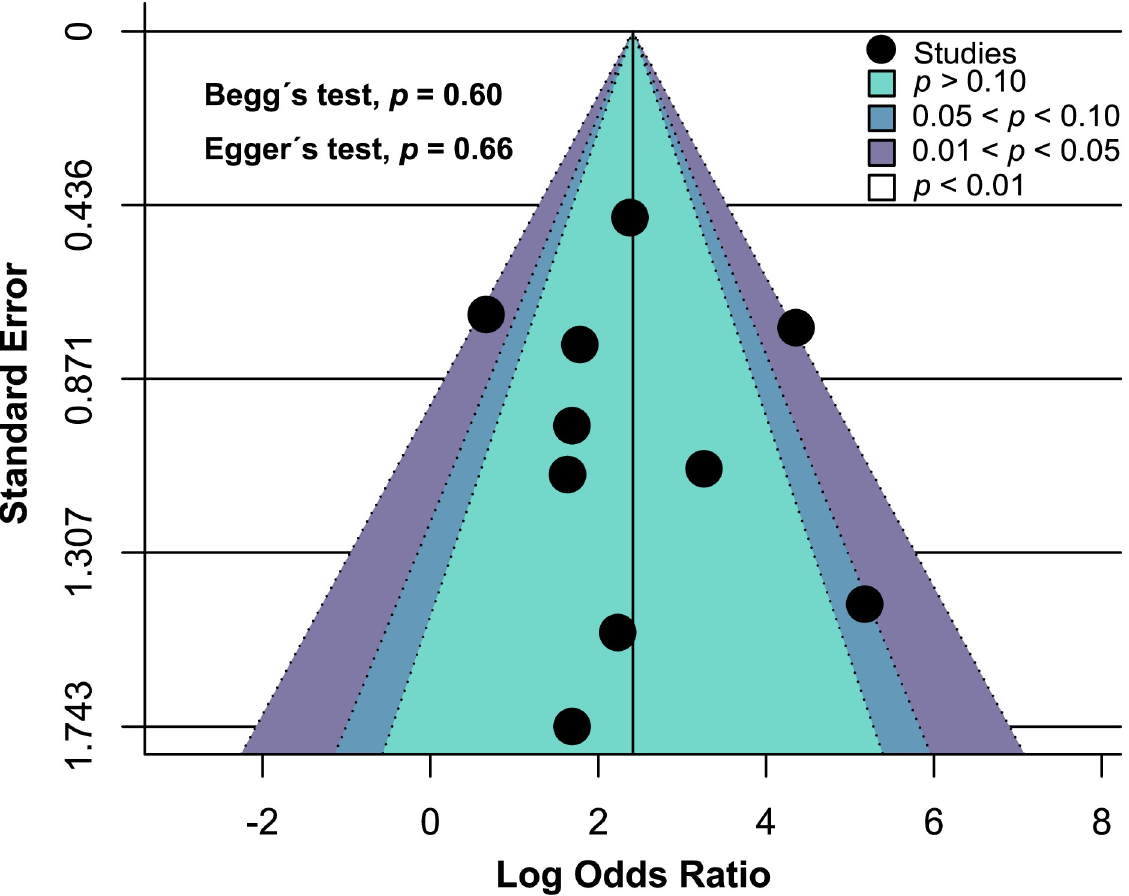
Fig 6. Contour-enhanced funnel plot of the included studies assessing aCL antibodies shows no evidence of publication